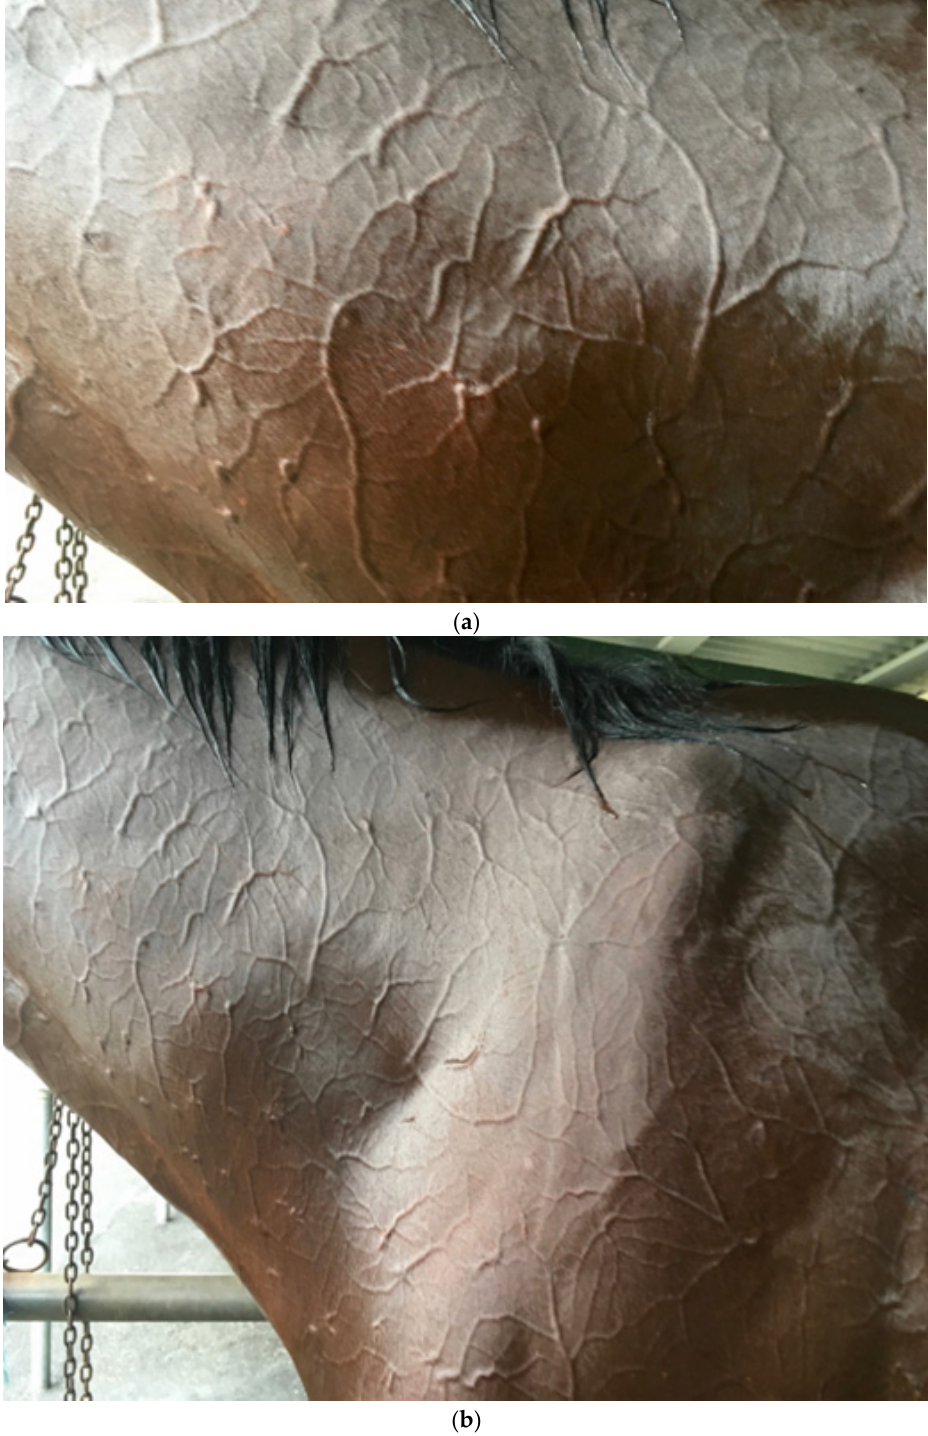
Figure 2. ( a , b ) shows the delicate pattern of vessels covering all the visible skin surface. Specialised anatomical structures called arteriovenous anastomoses (AVAs) connect arteries directly to veins, facilitating increases in peripheral blood flow without traversing capillary beds, permitting rapid and efficient heat loss [13]. Source—J Equine Vet Ed, 2021.